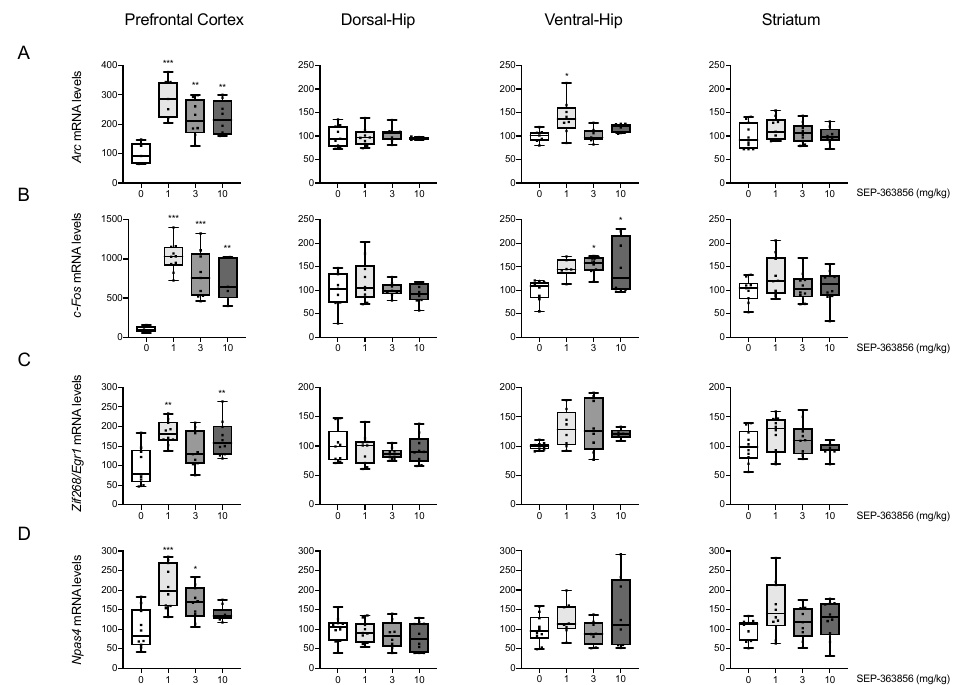
Figure 1. Modulation of IEGs expression following acute SEP-856 administration. The mRNA levels of Arc ( A ), c-Fos ( B ) , Zif268/Egr1 ( C ) and Npas4 ( D ) were measured in different brain regions of rats treated with vehicle or SEP-856 (1, 3 or 10 mg/kg). The data, expressed as percentage of vehicle-treated rats set at 100%, are represented as box-and-whisker plots of at least four independent determinations. For each box, the box boundaries indicate the first and third quartiles, the middle line specifies the median and the whiskers represent the lowest and highest values. * p < 0.05, ** p < 0.01, *** p < 0.001 vs. vehicle-treated rats (one-way ANOVA followed by Tukey post-hoc